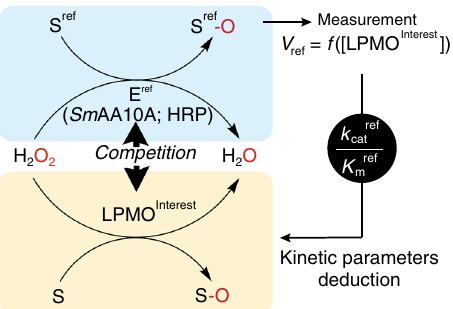
Fig. 1 Two enzymes, a reference enzyme (E ref , i.e., Sm AA10A or HRP) and an LPMO of interest compete for the H 2 O 2 co-substrate. The rate of the reference reaction ( v ref ) is a function of the concentration of the LPMO of interest. Provided with the k cat / K m (for H 2 O 2 ) value for reference reaction one can calculate the k cat / K m (for H 2 O 2 ) value for the LPMO reaction (oxidation of substrate, S). Note that, in the case of HRP, the reference substrate (S ref ) is oxidized but the oxygen atom is not incorporated into S ref